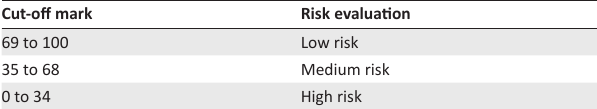
FIGURE 7: Third-year clusters from 2018 to 2021. TABLE 2: Students’ performance